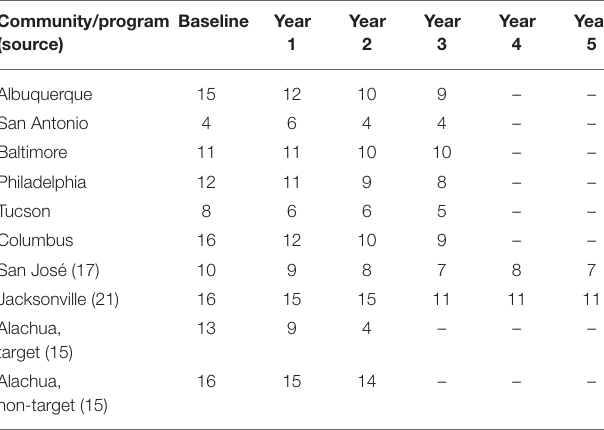
TABLE 7 | Annual reduction in feline intake for each of six 3-year CCPs per 1,000 human residents in each corresponding shelter service area, and comparison to similar programs in other